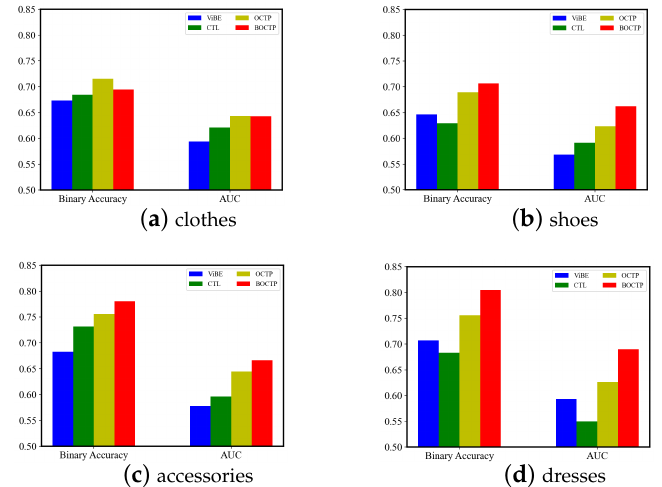
Figure 10. Ablation study on Street2Shop ‘all’ dataset for label-given task. Binary Accuracy and AUC on clothes, shoes, accessories and dresses are shown in the figure.